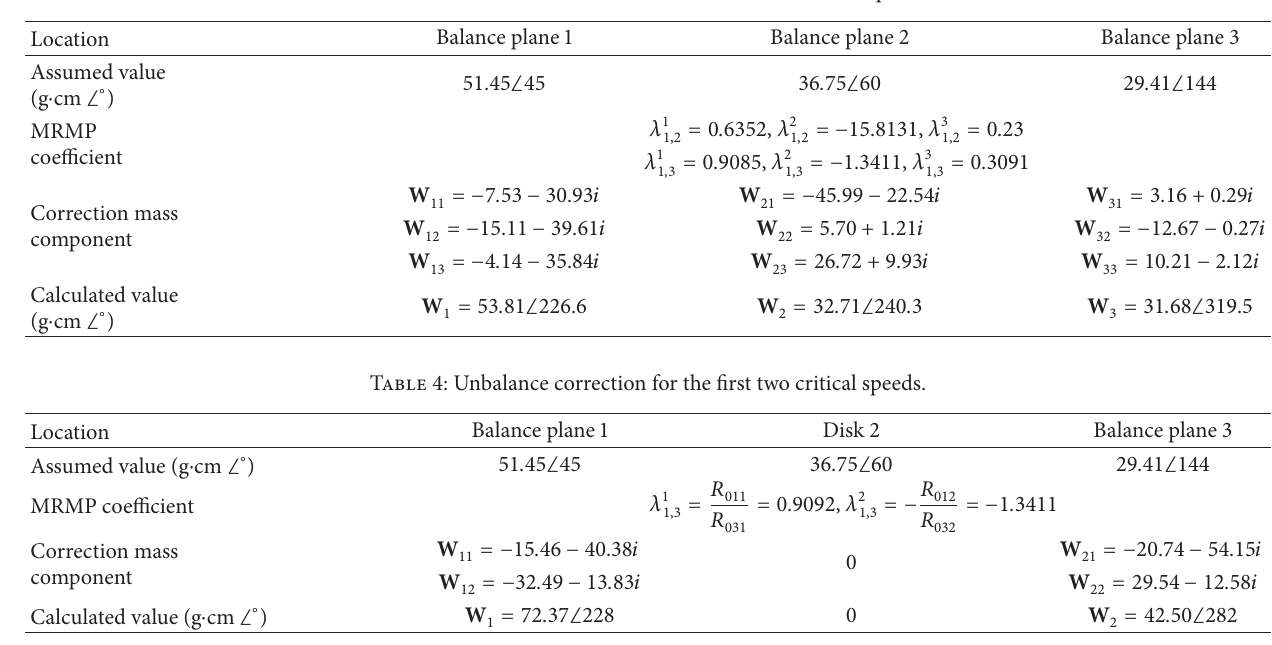
Table 3: Unbalance correction for the first three critical speeds.